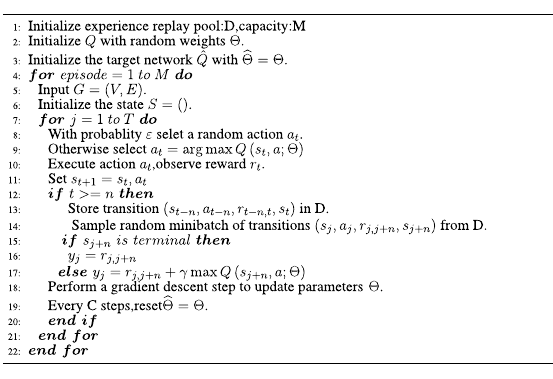
Algorithm 3. DQN